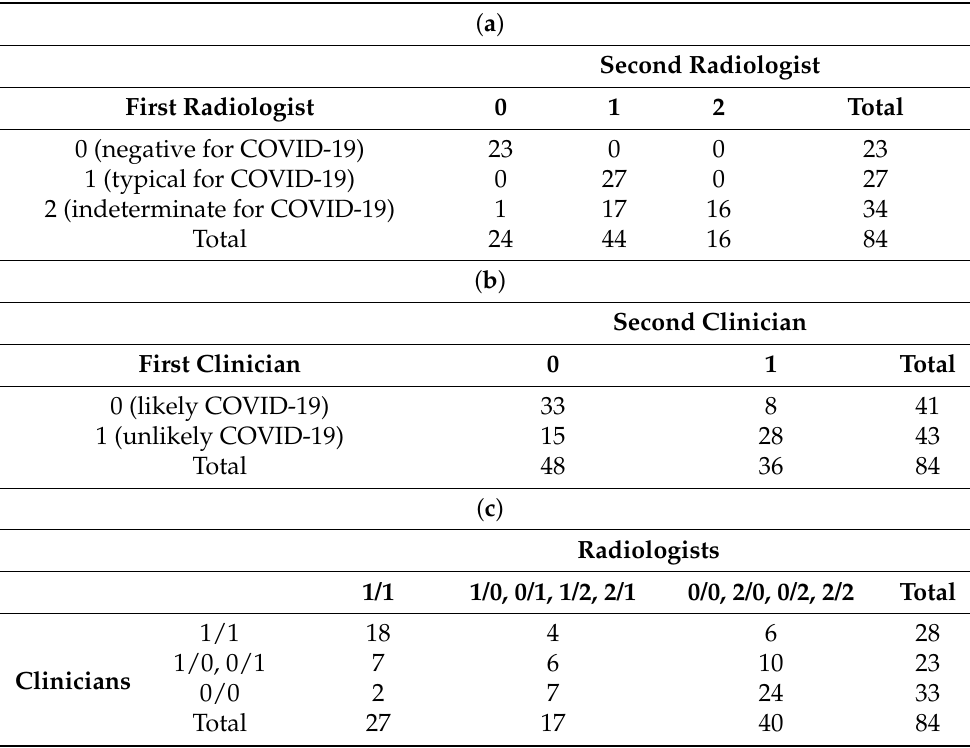
Table 1. Agreement for the diagnosis of COVID-19 between the two radiologists ( a ), the two clinicians ( b ), and radiologists vs. clinicians ( c